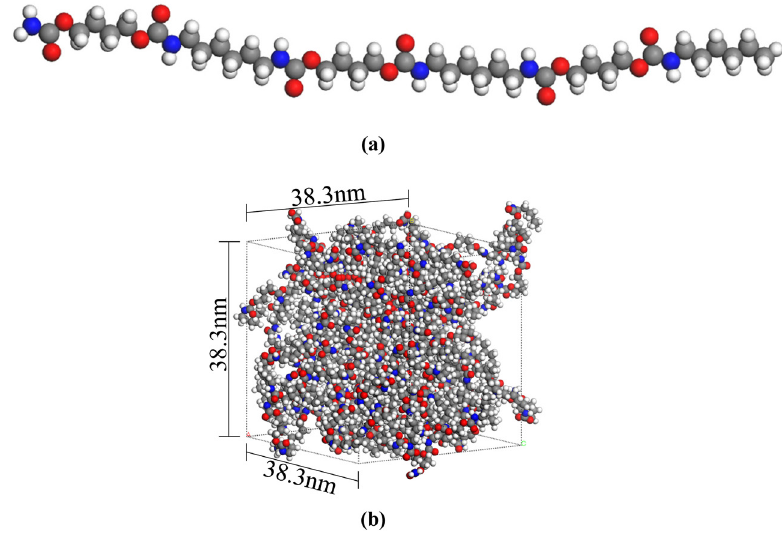
Figure 4: PU molecular model: ( a ) PU monomer molecular model ( n = 3 ) and ( b ) PU macromolecular